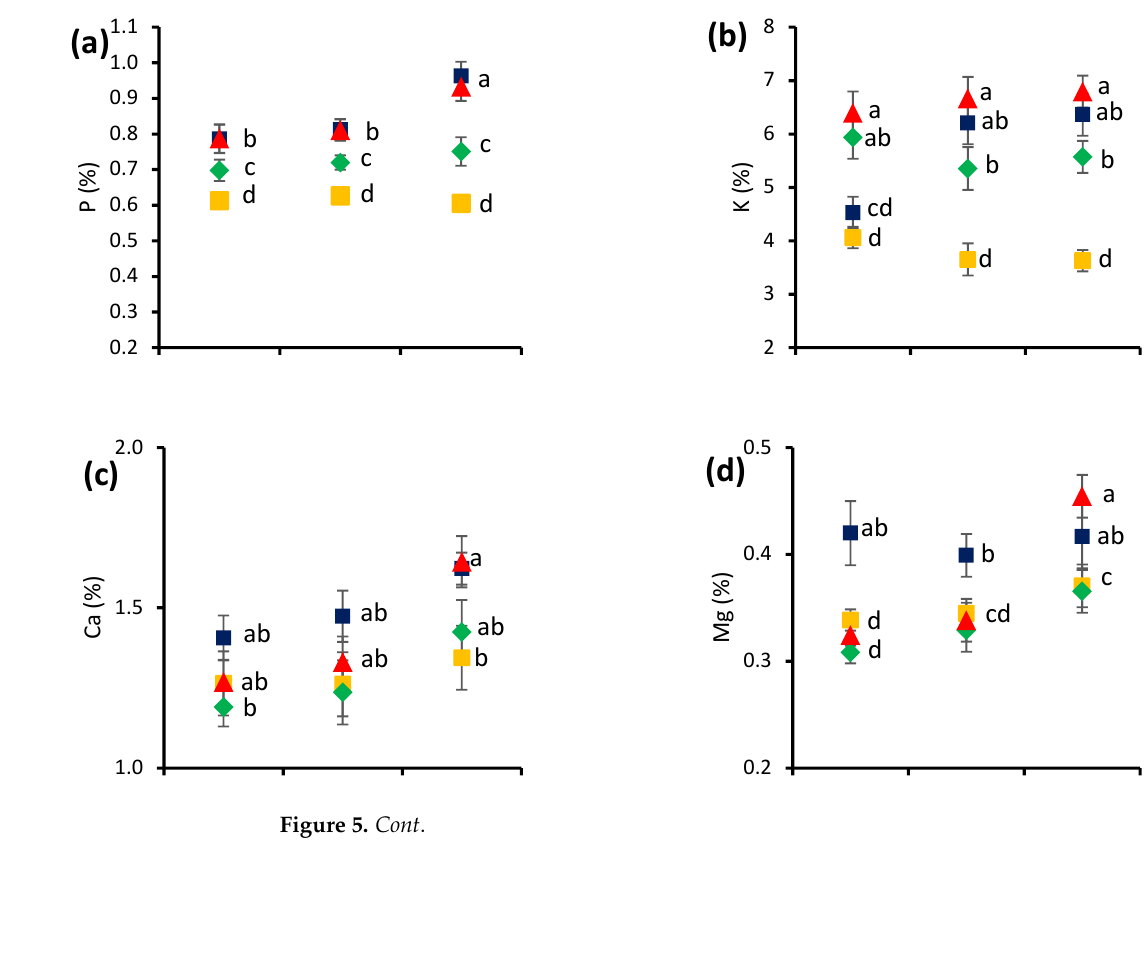
Figure 4. Means (±SE) of plant N content as influenced by different treatments. Means with the same letters are not significantly different ( p > 0.05) from one another using Tukey’s test.